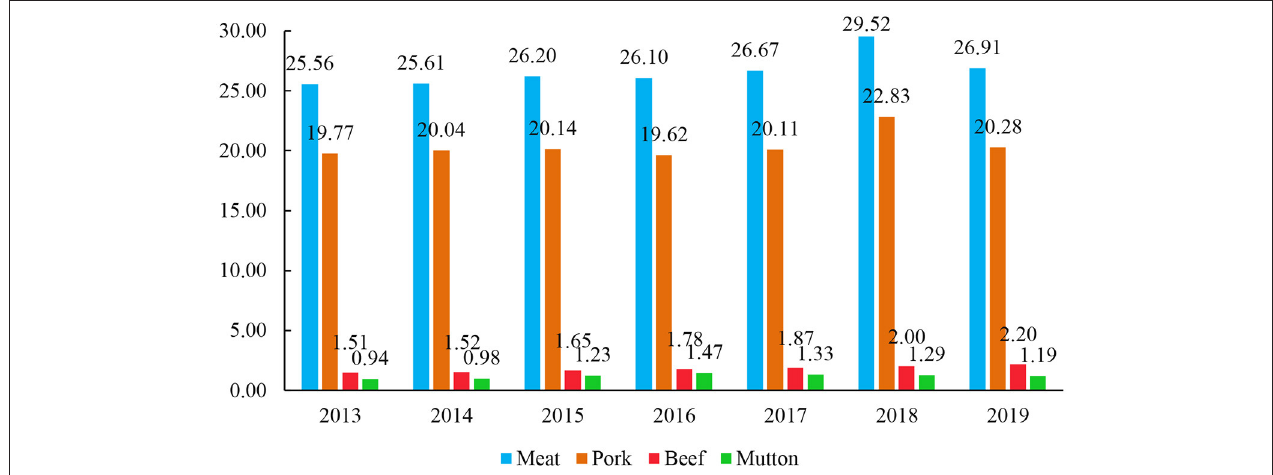
FIGURE 1 | Trends of per capita meat consumption (unit: kg) in China. China statistical